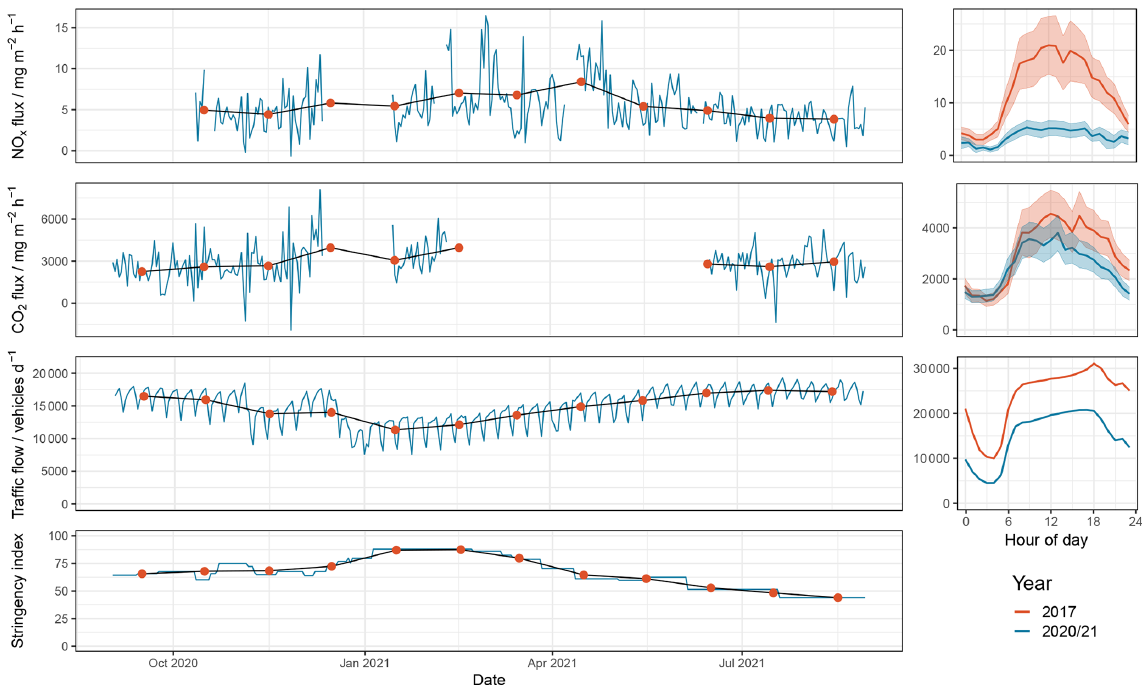
Figure 2. Time series from September 2020 to September 2021 for daily time-averaged NO x flux, CO 2 flux, traffic load around the tower and stringency index in the UK. Also shown are monthly averages for each variable as red dots centred around the centre of each month. Average median diurnal profiles with error bars (calculated as the combination of random and systematic errors in the flux calculations, as described by Mann and Lenschow (1994)) for the data are shown to the right in blue for 2020–2021 in comparison to those generated from the 2017 data in